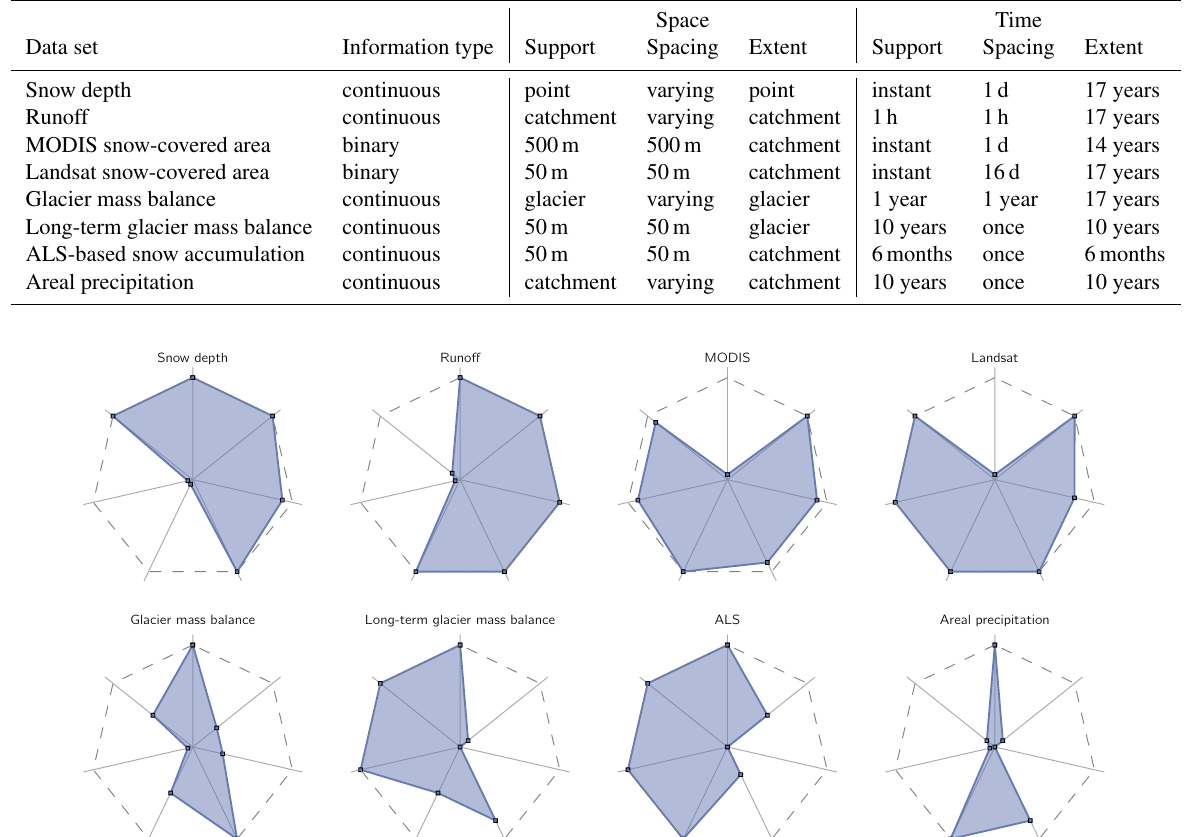
Figure 5. Radar charts (using the axis scales from Fig. 4) showing the observation scale of the validation data sets used in this study. The dashed gray heptagons represent an “optimal” validation data